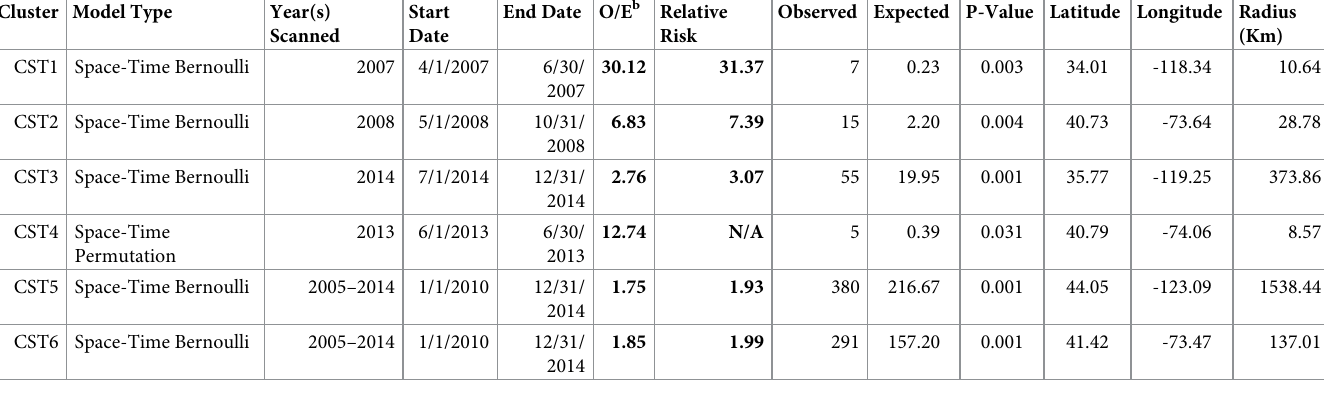
Table 7. Space-time clusters identified with the spatial scan statistic using Bernoulli and space-time permutation models, where there were statistically significant higher levels of dog-associated poisoning calls to the APCC a related to cannabinoids in the continental US (2005–2014). Cluster Model